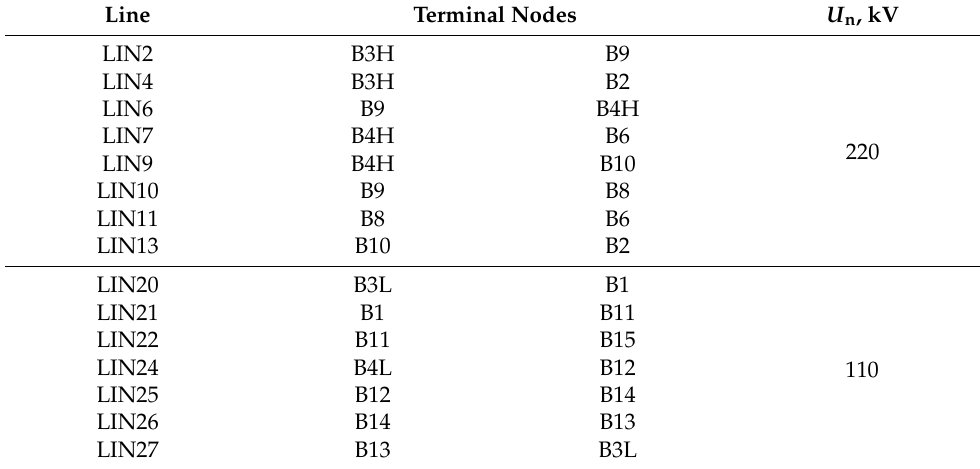
Table 2. List of power